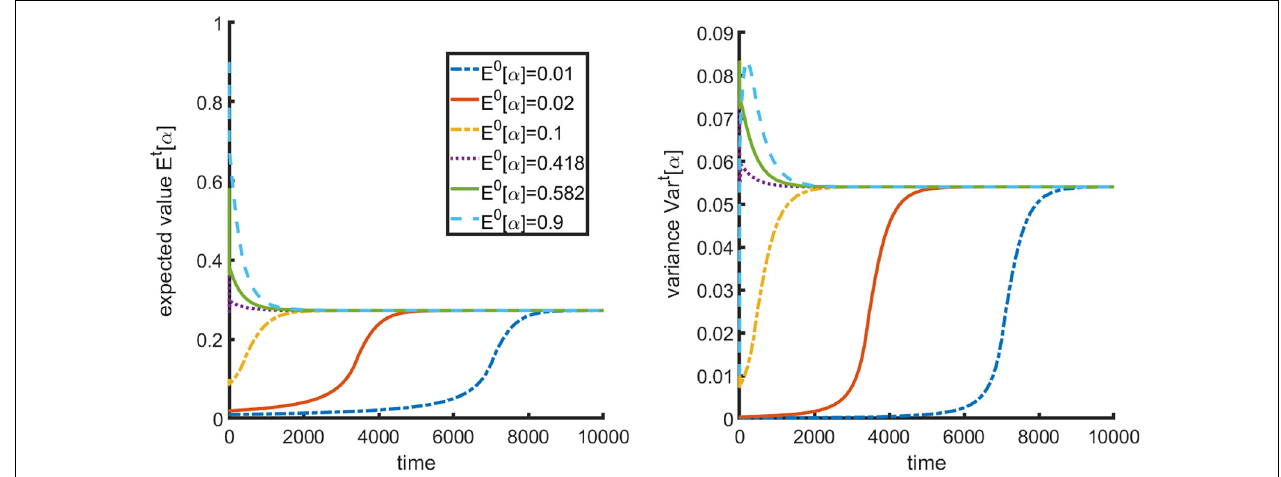
FIGURE 3 | Impact of initial distribution on final population composition. (A) Final mean strategy α and (B) variance are invariant to initial